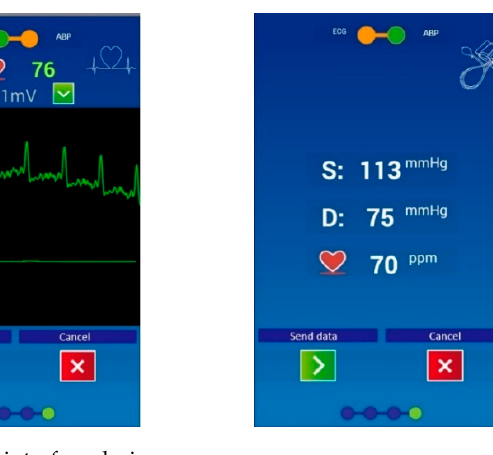
Figure 6. App interface